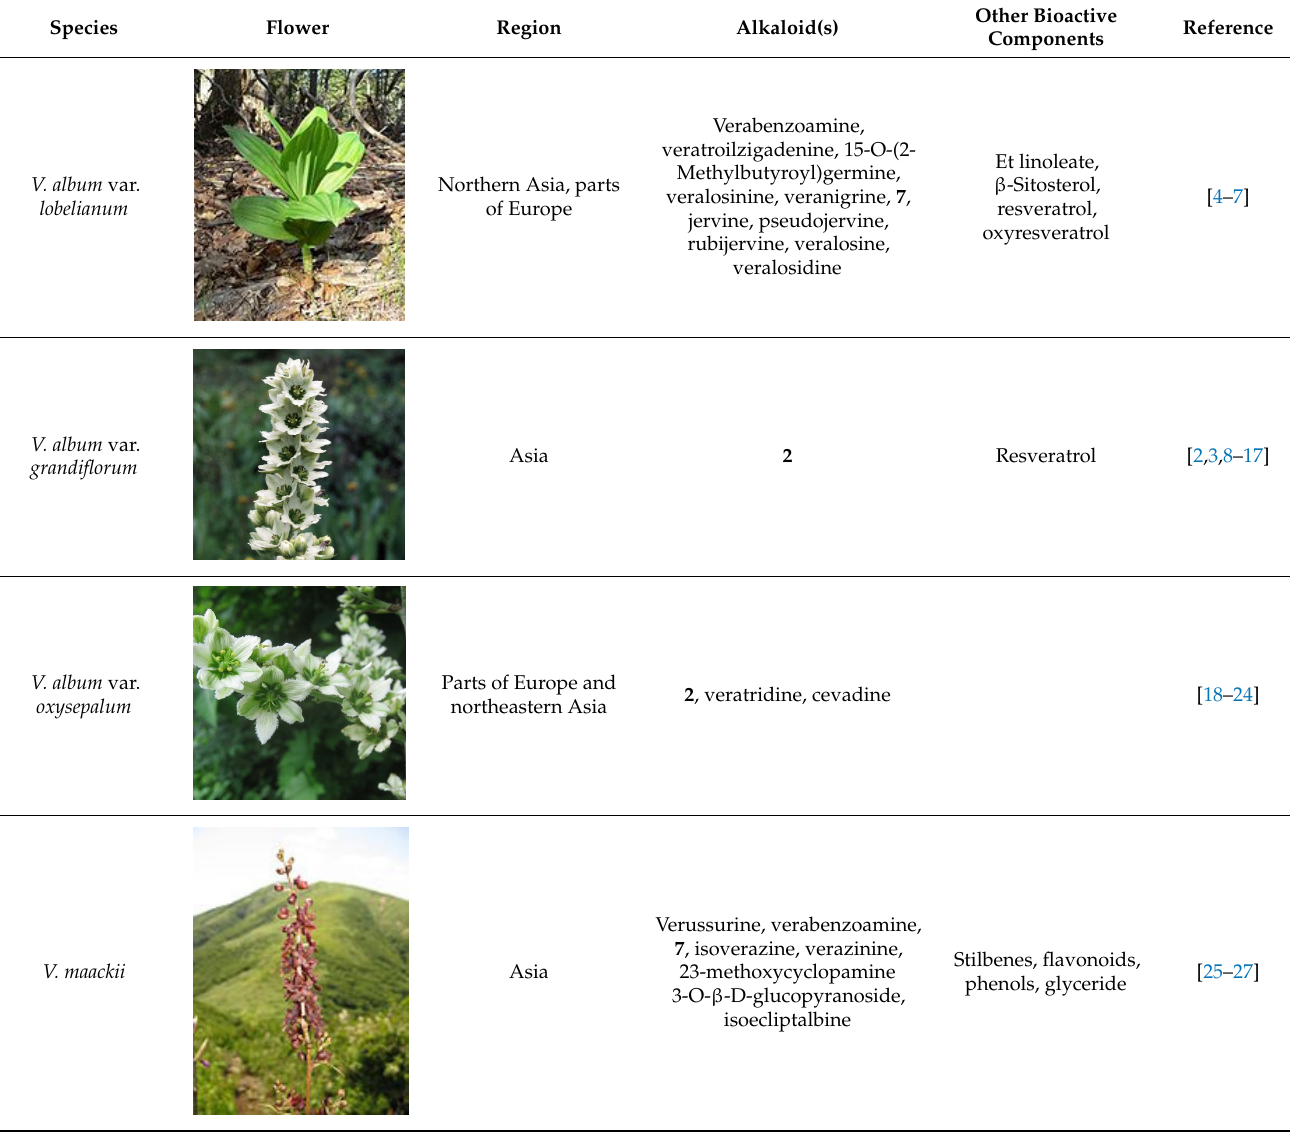
Table 1. Flower and geographic region for Veratrum spp. addressed in this review.